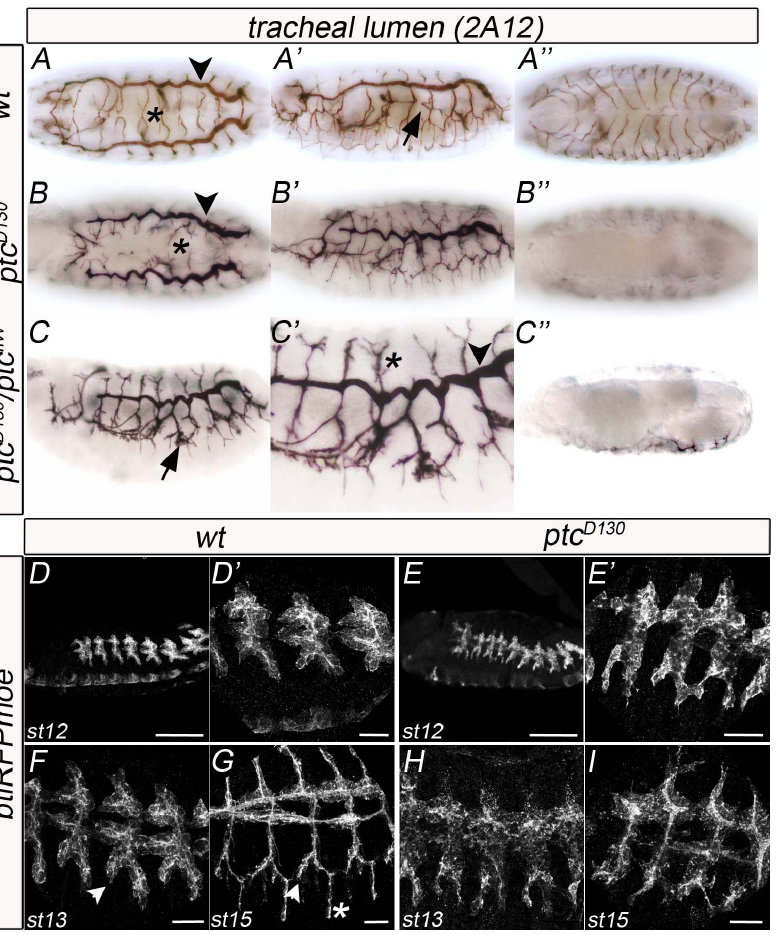
Figure 1. Ptc is required for tracheal morphogenesis. (A–C) Stage 16 wt (A) and ptc mutant (B–C) whole-mount embryos stained with the tracheal lumen antibody 2A12, using HRP immunohistochemistry for visualisation. A and B are dorsal views; A 9 , B 9 , C and C 9 are lateral views and A 0 , B 0 and C 0 are ventral views. A, A 9 and A 0 are images of the same embryo; the same for B and C. Arrows indicate the visceral branch (VB), arrowheads the dorsal trunk (DT) and asterisks the dorsal branch (DB). (D–I) Lateral views of stage 12 to 15 wt (D, F, G) and ptc mutant (E, H, I) btlRFPmoe embryos stained with an anti-RFP antibody to visualise all tracheal cells. D 9 and E 9 are magnifications of D and E, respectively. Anterior is left in all panels; scale bars are 100 m m in D–E and 20 m m in F–I. Arrowheads indicate the lateral trunk anterior (LTa) and asterisks indicate the ganglionic branch